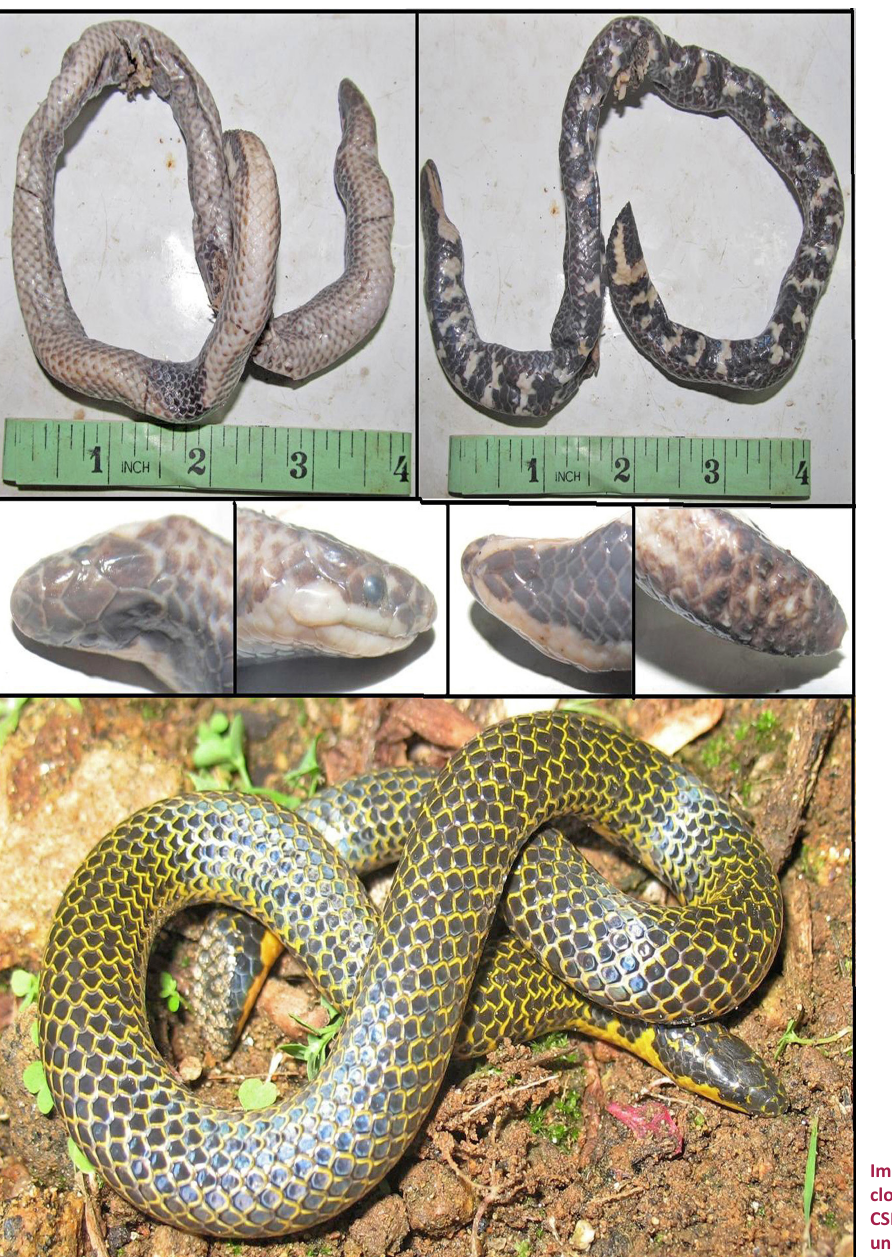
first lateral blotch present on the neck; eye pale white; inside of mouth pale rose to grey deeper inside; venter brownish-grey with 32, paired, off-white blotches, each blotch two to three scales large; blotches either alternate or rarely conjoin to form cross bars; subcaudals deep brown enclosed by two parallel stripes laterally, joined together anteriorly by a cross bar at the anal scale; tail shield dorsally with dark brown swatches on a pale whitish background.